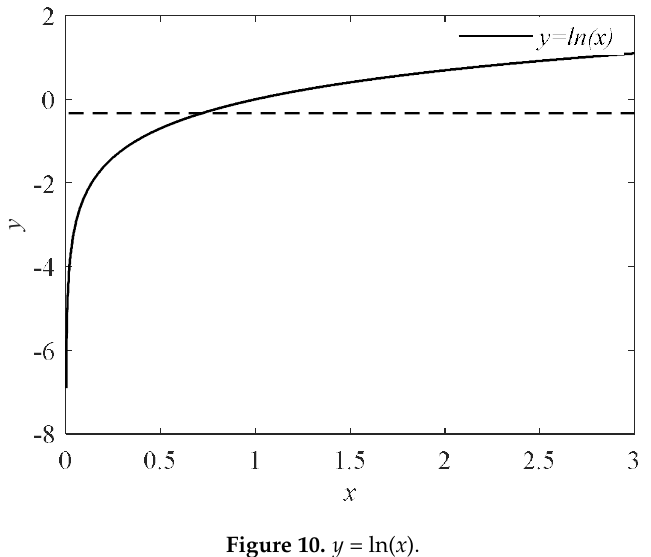
Figure 10. y = ln( x ).